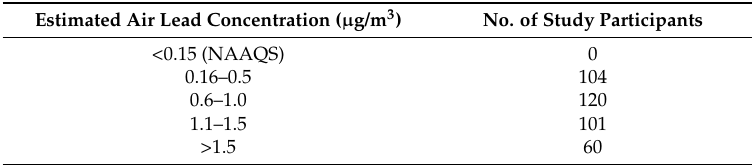
Table 3. Air lead concentrations for each participant’s coordinates estimated by inverse squared distance weighting. The United States Environmental Protection Agency’s National Ambient Air Quality Standard for lead in total suspended particles is 0.15 µ g/m 3